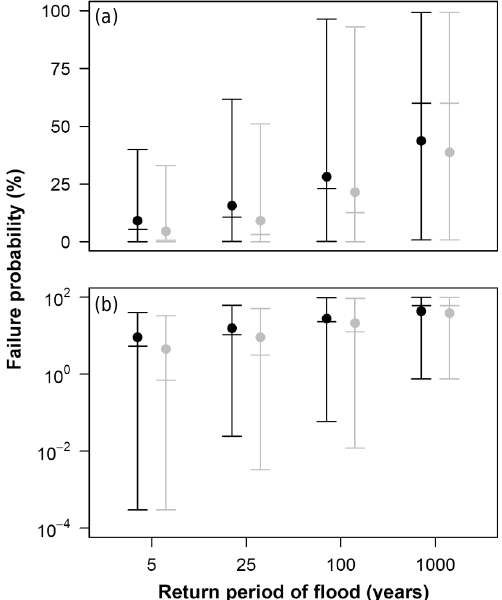
Figure 5. Estimated bridge failure probabilities as a function of flood event severity, expressed in terms of the return period of the flood event, conditional on a preceding flood event of 100-year re- turn period having occurred with no intervening maintenance ac- tion. Upper and lower panel show the same data, plotted on different